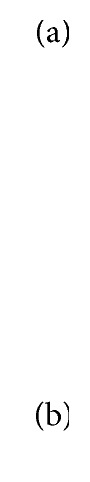
Detail of the neoplasm, composed of nests and solid sheets of cells with abundant and clear cytoplasm. The nuclei are enlarged with some conspicuous nucleoli (H&E 200x).